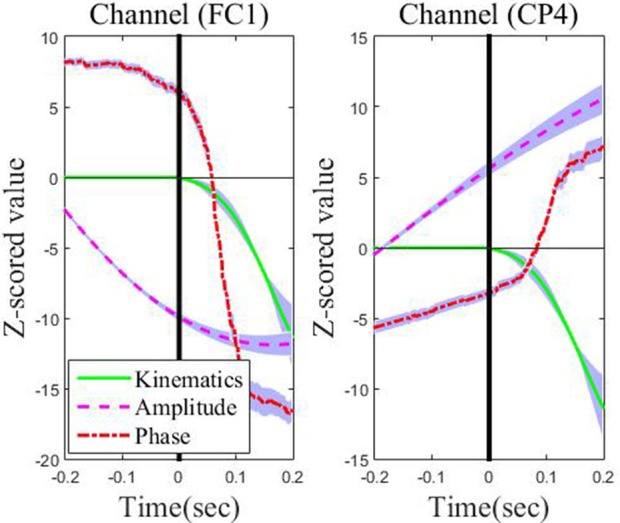
The across-subject and across-session time course of low-delta EEG phase features and amplitude features in the representative channels (FC1 and CP4) preceding movement onset (the vertical line on 0 s) and during the leftward movement. The thick lines denote the average patterns, and the range of standard deviation is plotted with a shaded background in blue.